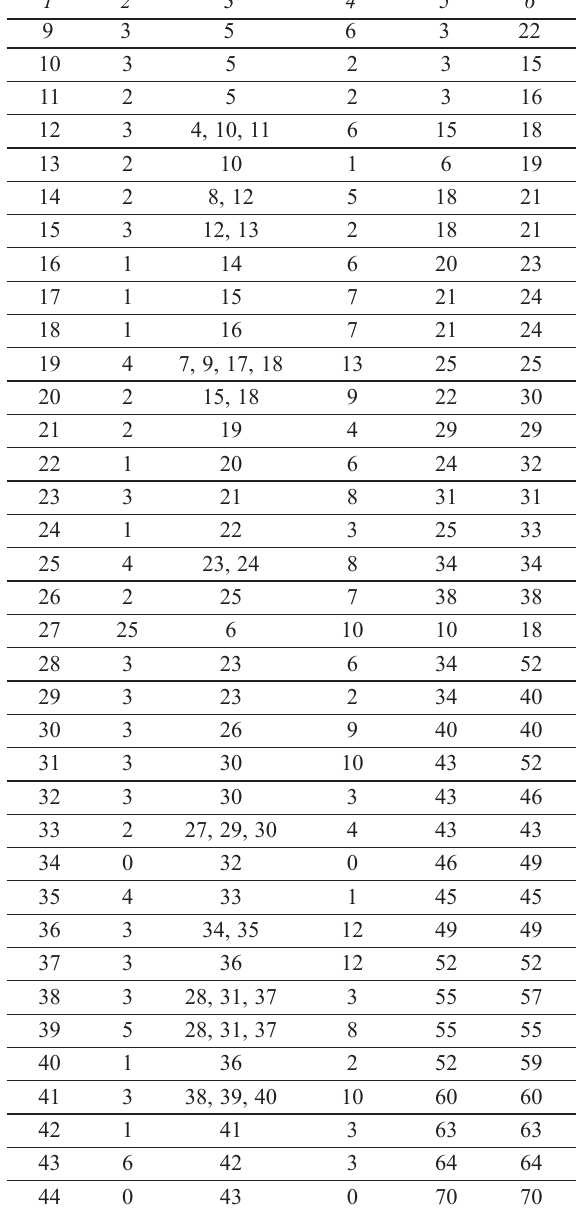
Table 2. Project information Act. ID